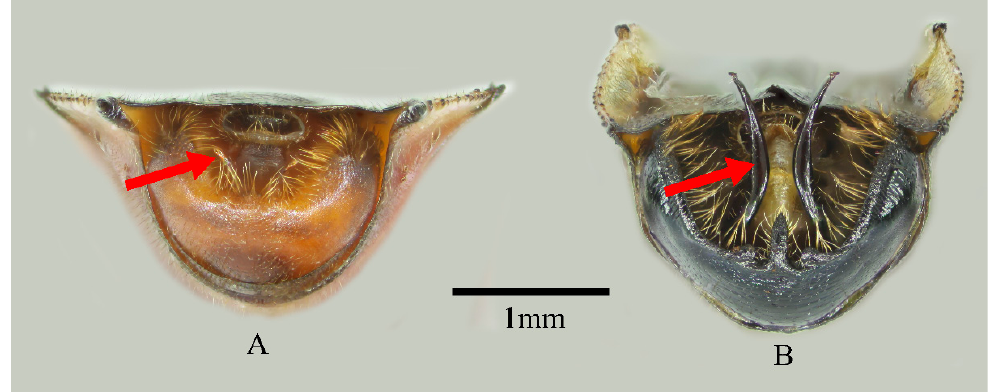
Figure 2. Posterior view of pygophore. ( A ) N. bispina sp. nov ., and ( B ) N. elegans .